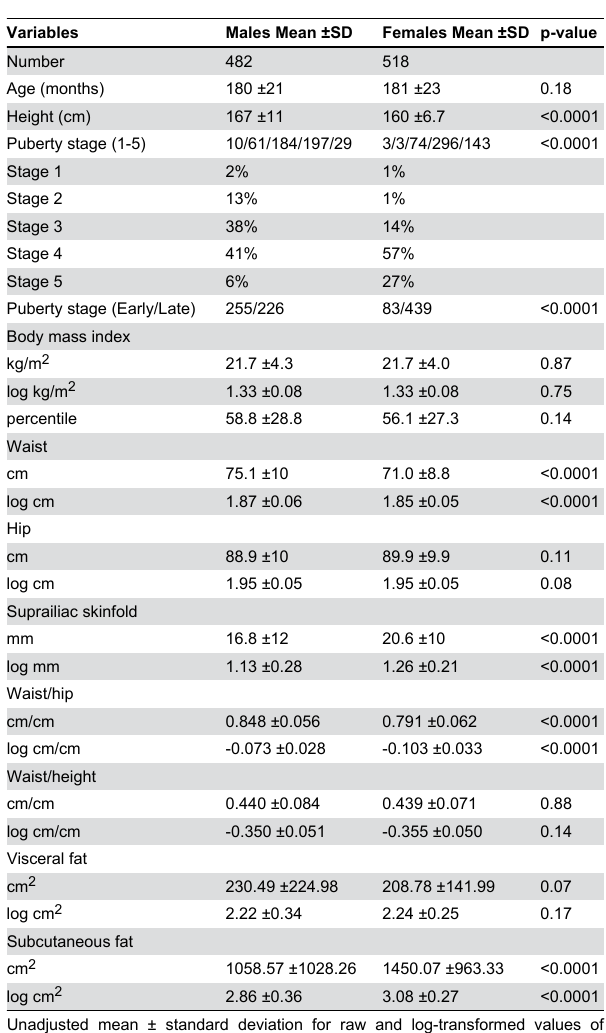
Table 1. Basic characteristics and adiposity measures of studied adolescent males and